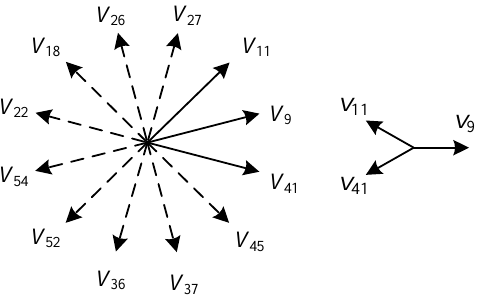
Figure 11. Three adjacent large vectors in the fundamental wave subspace mapped onto the har- monic subspace.